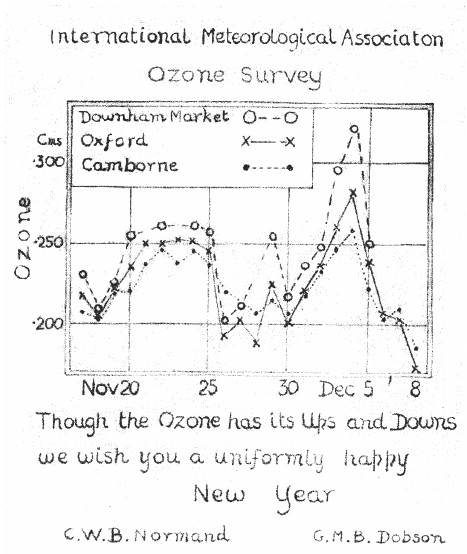
Figure 3. New Year’s card with data from Downham Market,